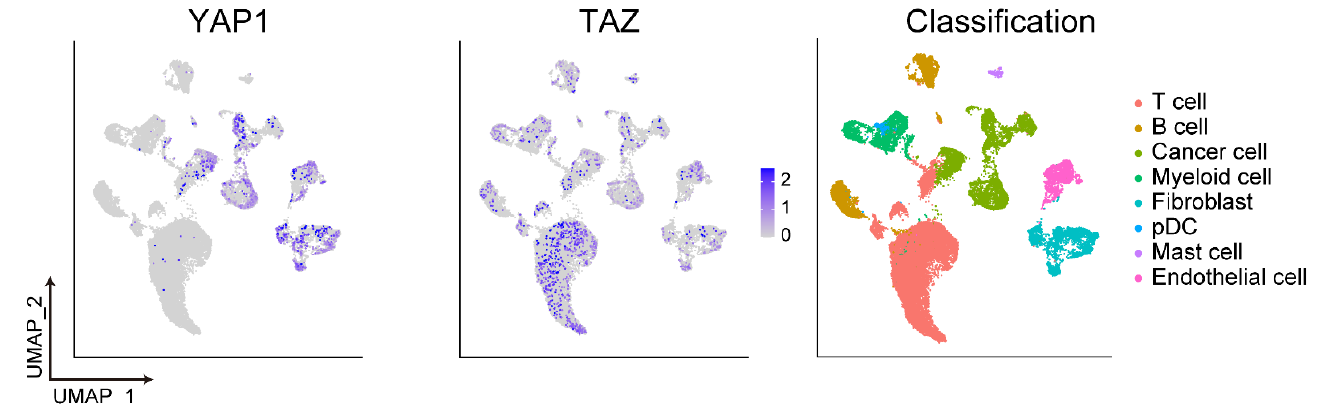
Figure 4. The expression of YAP1 and TAZ in the GC microenvironment. By scRNA-seq analysis, YAP1 was predominantly expressed in cancer cells, cancer-associated fibroblasts, and endothelial cells, while the immune cells (T and B cells) demonstrated less YAP1/TAZ expression. TAZ expression was diffusely distributed in the different cell types, with slightly higher expression in T cells.